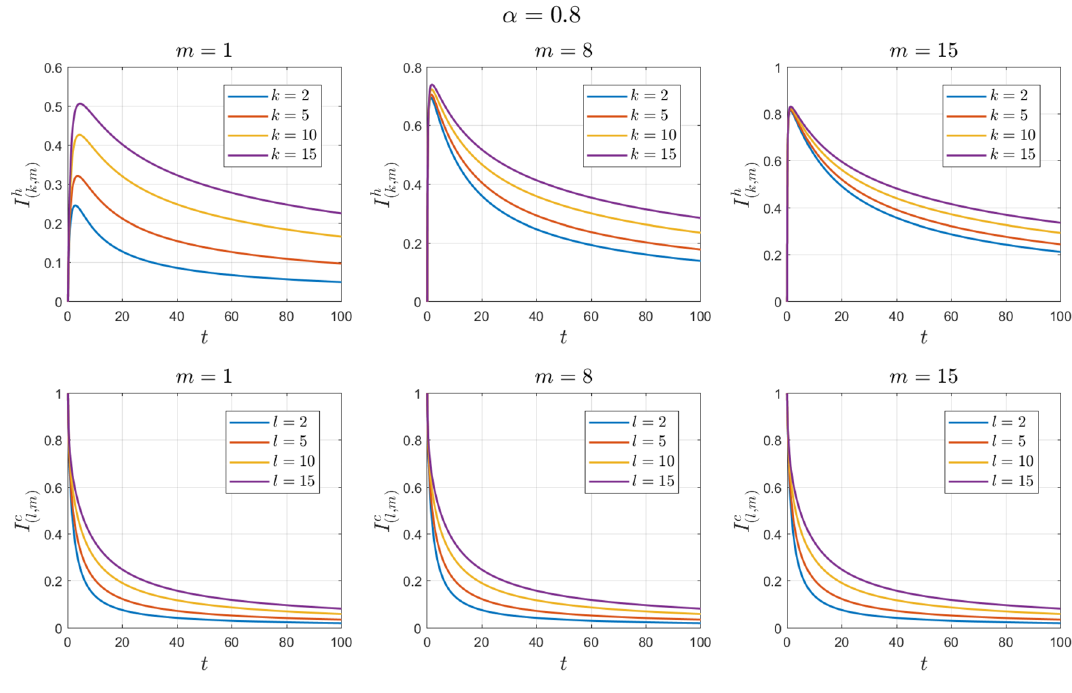
= ( 0 ) , I h ( 0 ) , S c ( 0 ) , I c ( 0 ) S h ( k , m ) ( k , m ) ( l , m ) ( l , m ) (cid:31) (cid:30)